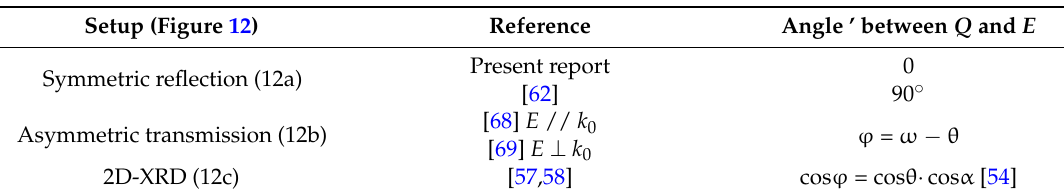
Table 1. Angles between electric field E and scattering vector Q .